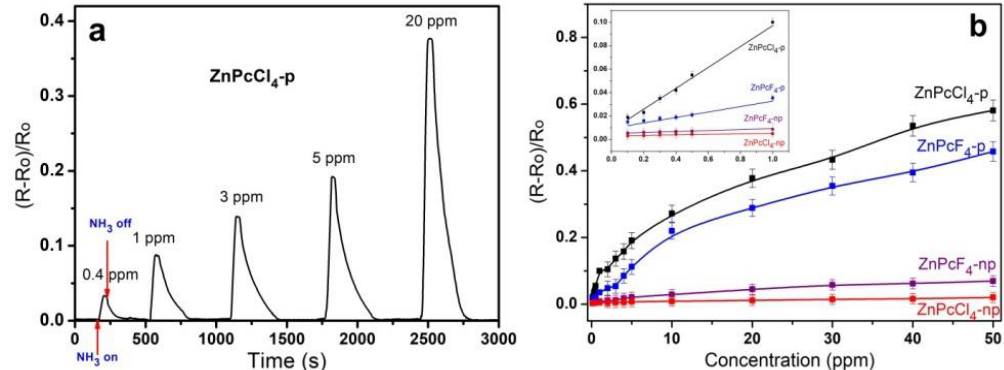
Figure 7. ( a ) Real-time sensor response of a ZnPcCl 4 -p film to ammonia, measured at RH 10% and 25 °C. ( b ) Dependence of the sensor response of ZnPcF 4 -np, ZnPcF 4 -p, ZnPcCl 4 -np, and ZnPcCl 4 -p sensing layers on ammonia concentration.